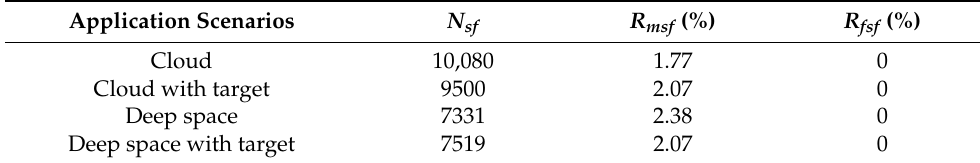
Table 5. The situation of flickering pixels suppressed by proposed